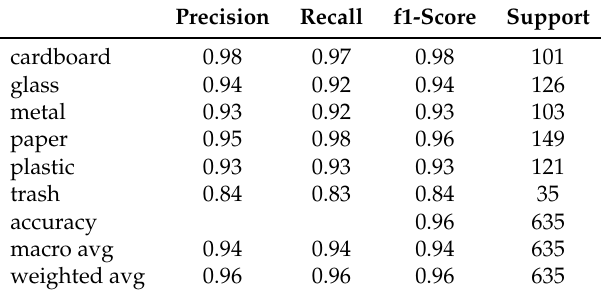
Table 2. Classification report on test data.